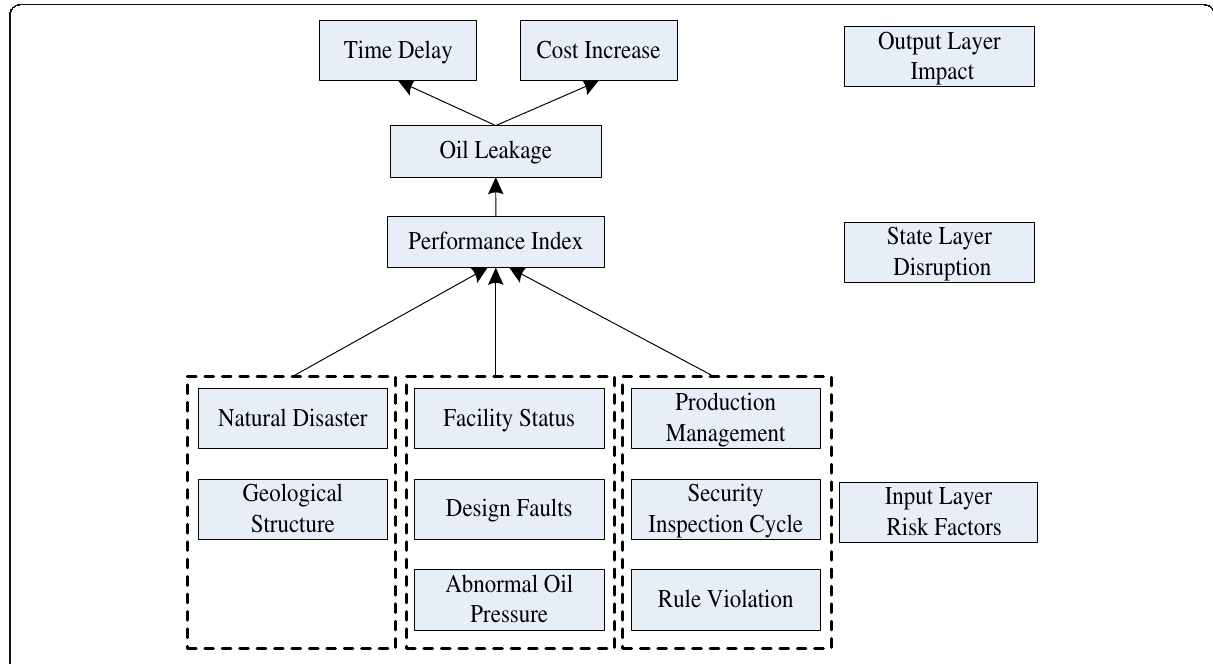
Fig. 1 The causal relation model of the disruption chain in